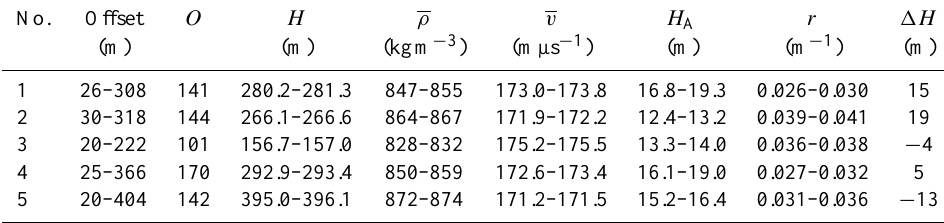
Table 1. Summary of the WARR results from sites 1–5 in terms of range of offsets, number of offsets ( O ), ice thickness ( H ), depth- averaged density ( ρ ), depth-averaged radio-wave propagation speed ( v ), firn-air content ( H A ), the decay length ( r ) parameterizing the depth– density function, and the deviation from hydrostatic equilibrium ( (cid:49)H ). The ranges correspond to the lower and upper limits of five reflector combinations at each site (four reflector combinations contain three reflectors, and one combination contains all four reflectors).